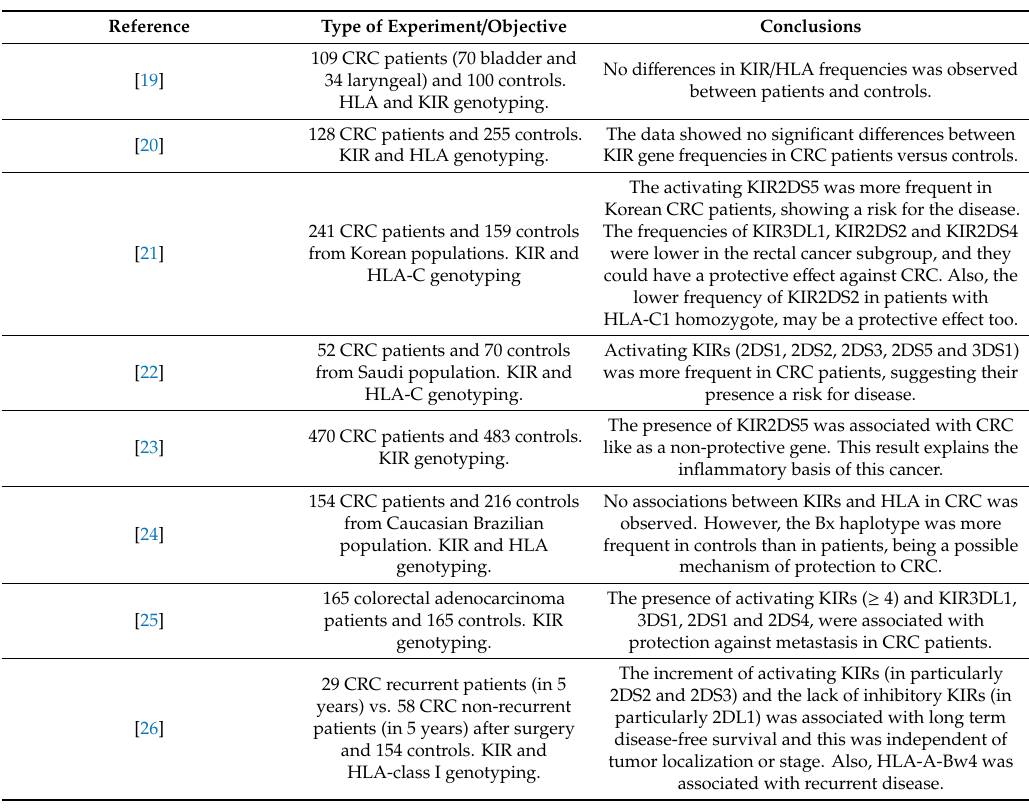
Table 6. Basic research studies showing the associations between KIR and HLA in CRC